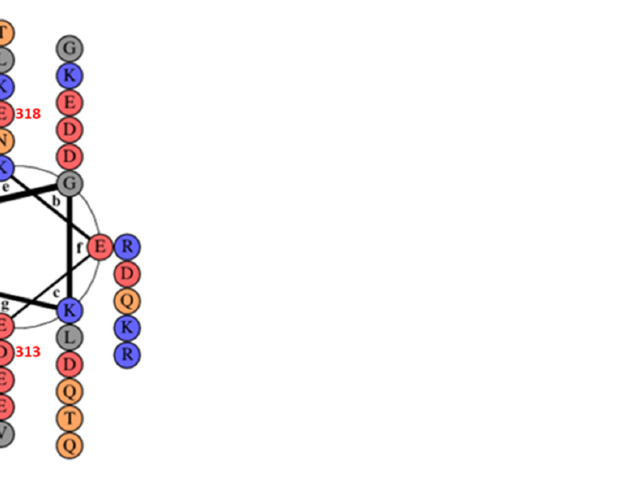
Figure 7. Helical wheel diagram of human Par-4 LZ dimer. The red dashed line indicates inter-helical charge repulsion between the two acidic residues D313 and E318.